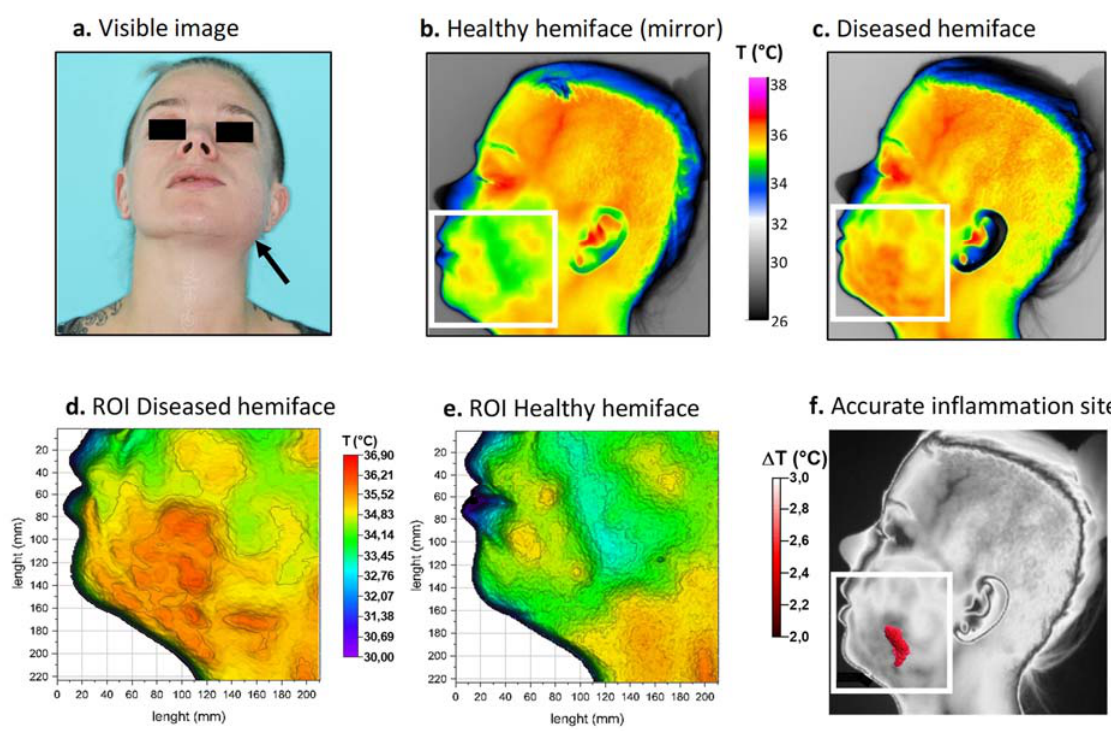
Figure 4. Thermal procedure in patient 2. ( a ) Front view visible image of the patient; ( b ) Returned (mirror) thermal image of the healthy hemiface with corresponding ROI; ( c ) Thermal image of the diseased hemiface with the same ROI; ( d , e ) 3D representations of the ROI weighted by temperature; ( f ) Resulting site of highest inflammation. White boxes correspond to the ROI.